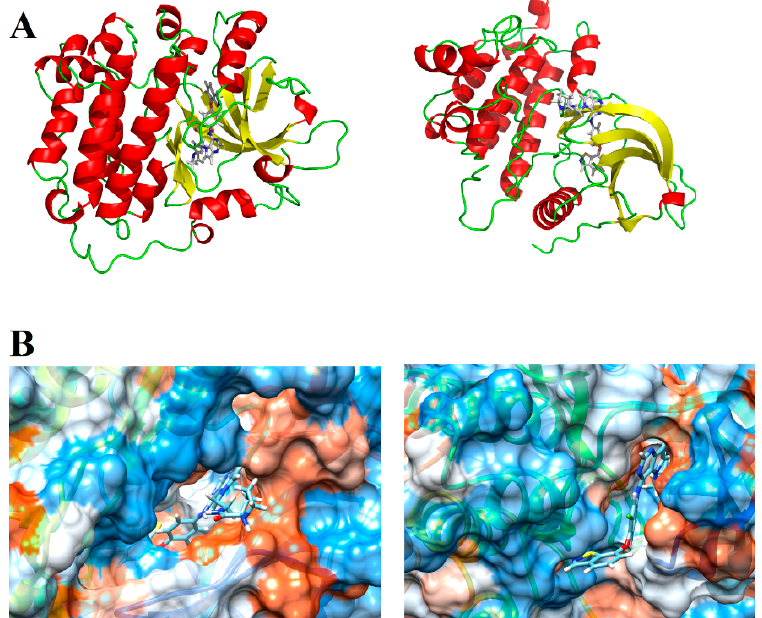
Figure 11. ( A ) Tridimensional structure of EGFR and HER-2; and ( B ) hydrophobic (orange) and hydrophilic (blue) surfaces of the EGFR and HER-2 active sites, respectively.